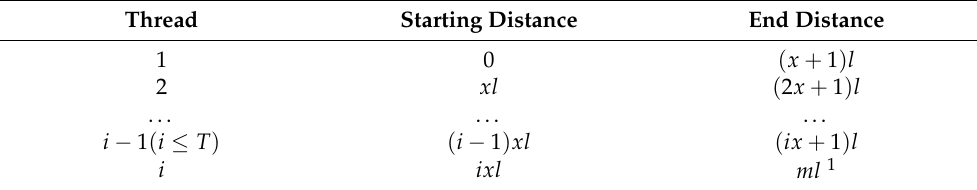
Table 2. Execution range of each thread of the iterative ISTTWN algorithm using multithreading. Thread